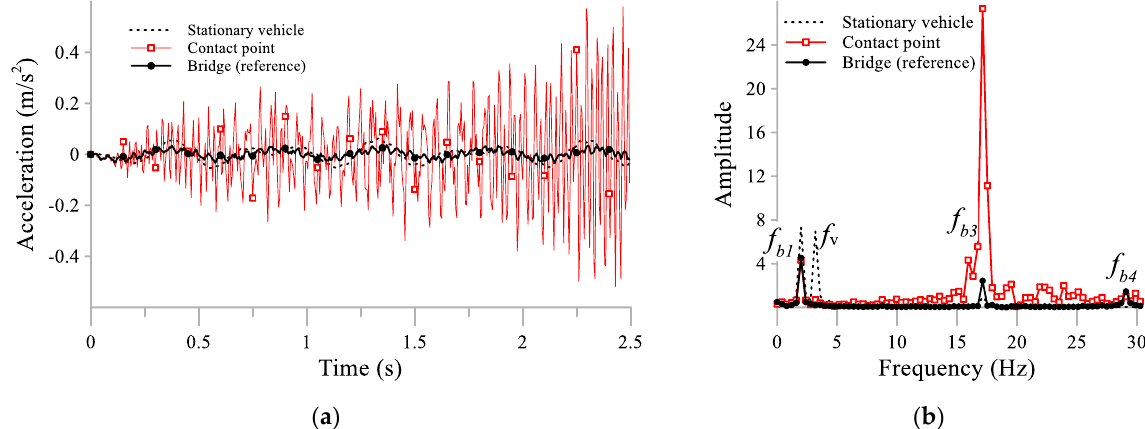
Figure 14. Road roughness effects on an undamped stationary vehicle and its contact-point and bridge ( a ) acceleration response, along with ( b ) the acceleration spectra.